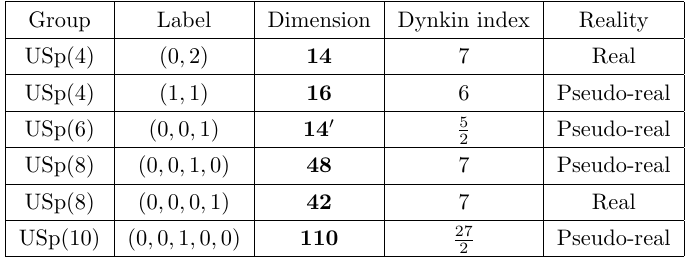
Table 15 . Various group theory data for USp(2 N ) representations associated with tensors with more than two indices. Here the group entry stands for the group in question, and the label entry stands for the standard Dynkin label of the representation. The remaining entries list the dimension, Dynkin index (AKA quadratic Casimir) and the reality properties of each